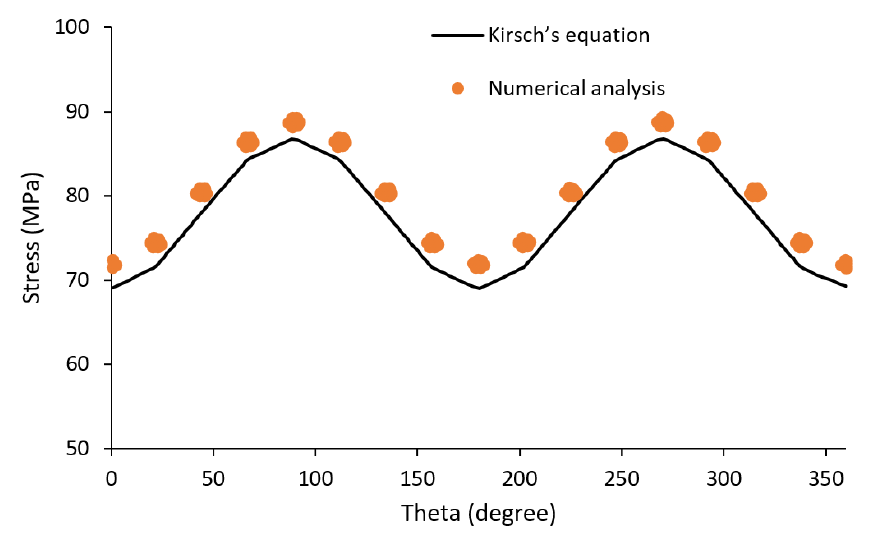
Figure 17. Radial stress distribution obtained from numerical modeling and the analytical solution of Kirsch’s equation around the wellbore-D in the Azar oilfield.